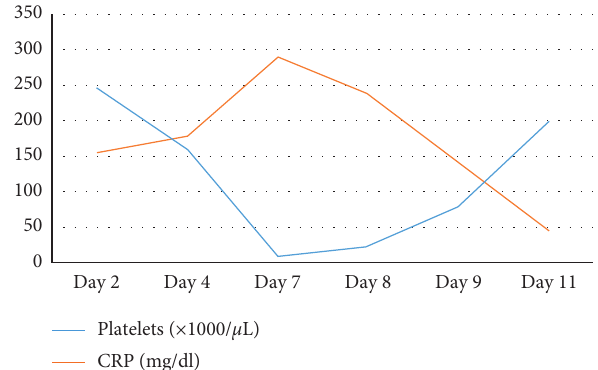
Figure 2: Image showing the trends of platelet and C-reactive protein with postoperative